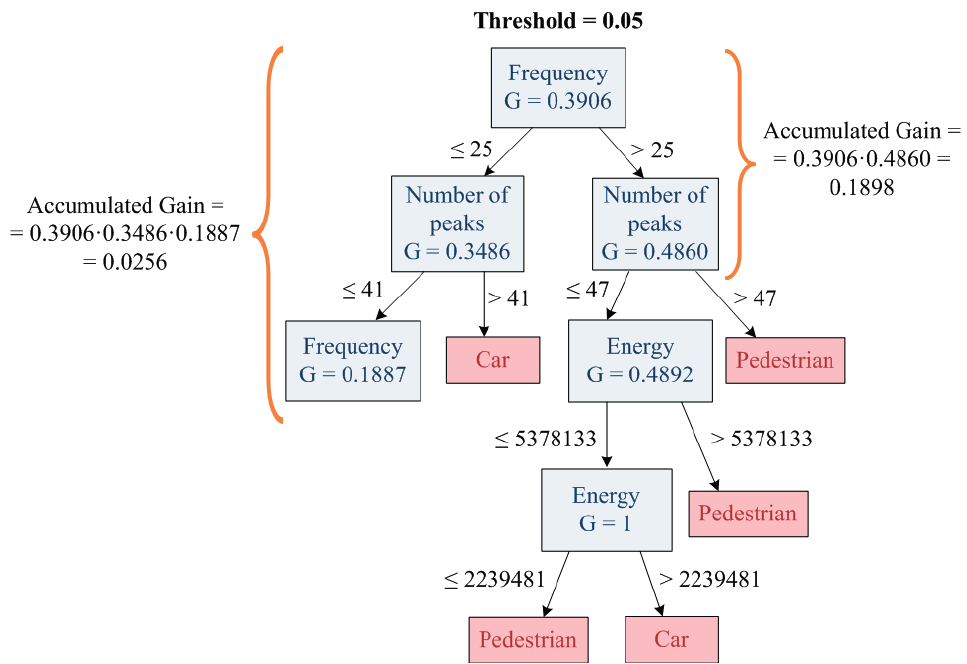
Figure 3. Pruning